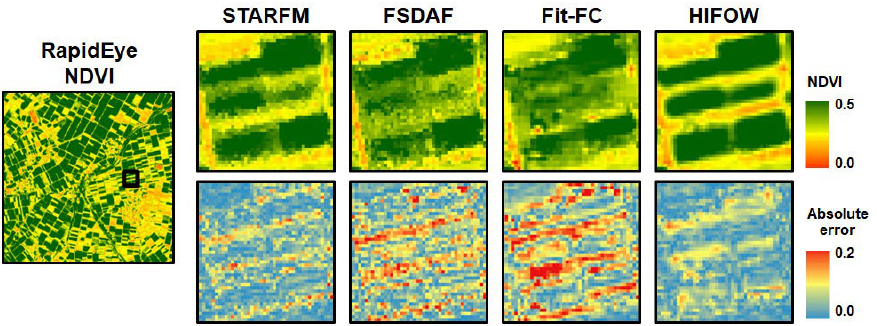
Figure 12. NDVI prediction results (first row) and absolute error distributions (second row) at the zoomed sub-area on Site 1. The sub-area marked with the black box in the left RapidEye NDVI image is